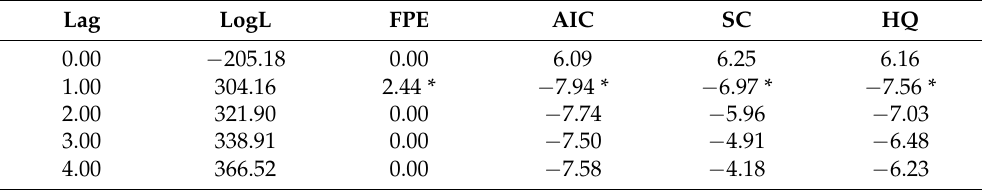
Table 5. Optimum Lag Length.